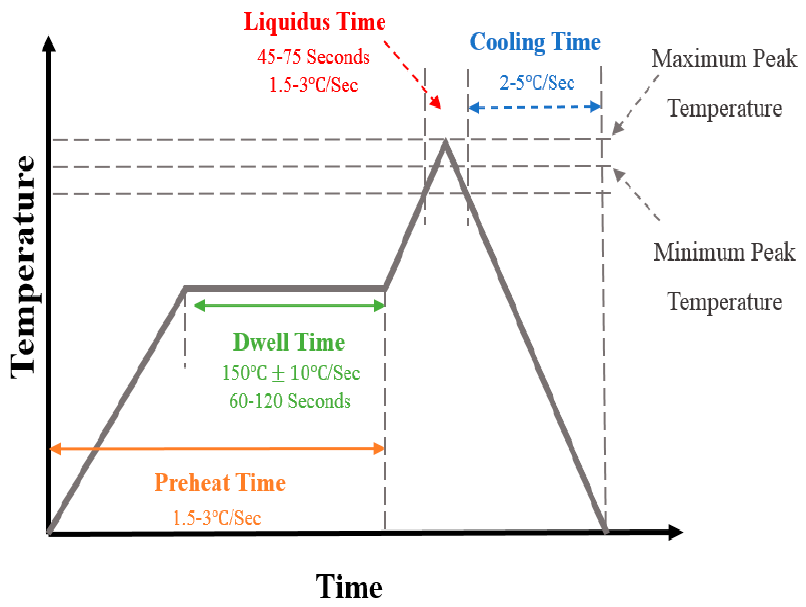
Figure 2. A typical temperature profile.